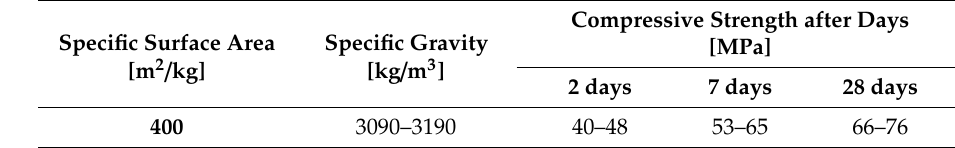
Table 2. Physical properties of